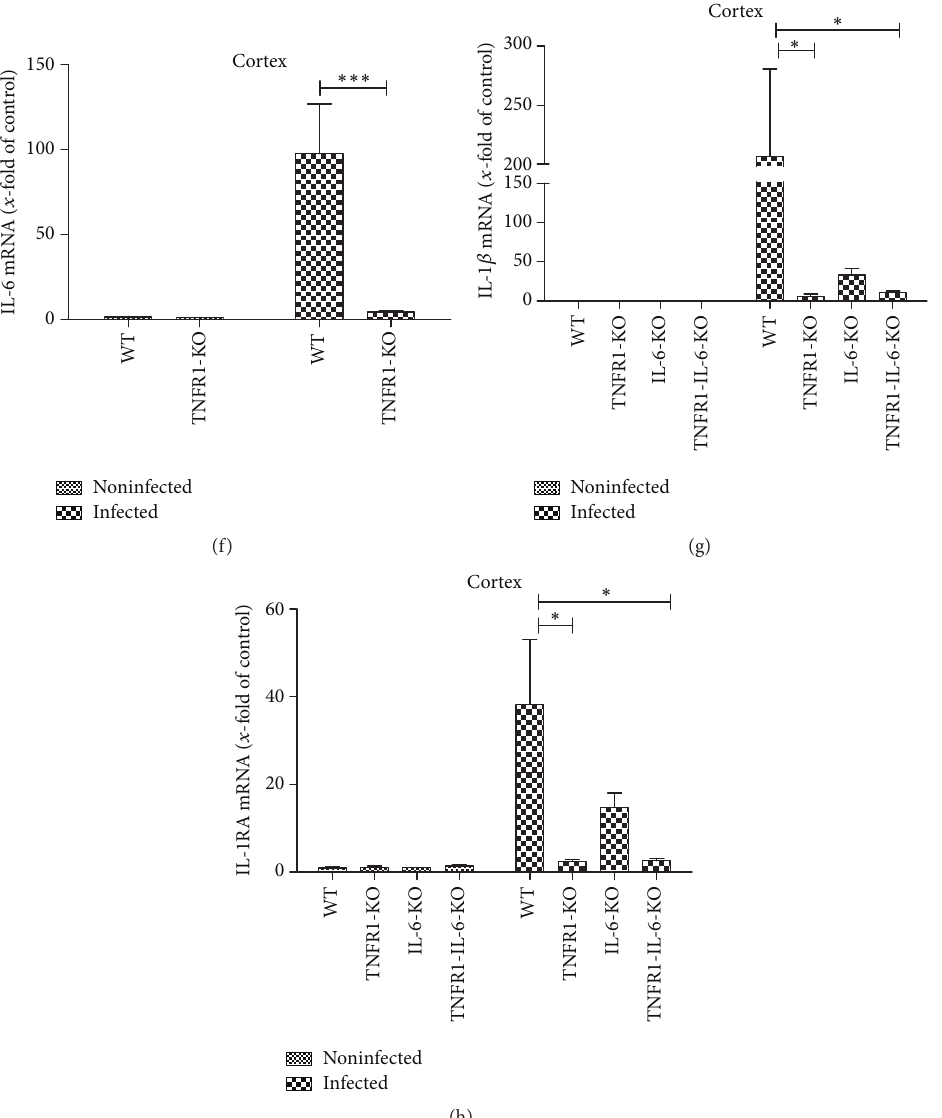
Figure 5: Analysis of innate immune response after pneumococcal meningitis in different brain regions. 30 h after subarachnoid infection with Streptococcus pneumoniae , mRNA expression of TNF- 𝛼 (a and e), IL-6 (b and f), IL-1 𝛽 (c and g), and IL-1RA (d and h) was determined in the hippocampal formation and cortex of TNFR1-, IL-6-, or TNFR1-IL-6-KO and WT mice by real-time RT-PCR. Data were assessed from five independent experiments in duplicate. An asterisk indicates a significant difference between infected WT and infected TNFR1-, IL-6-, or TNFR1-IL-6-KO mice as determined by ANOVA followed by Bonferroni test ( ∗ 𝑝 < 0.05 ; ∗∗ 𝑝 < 0.01 ; ∗∗∗ 𝑝 < 0.001